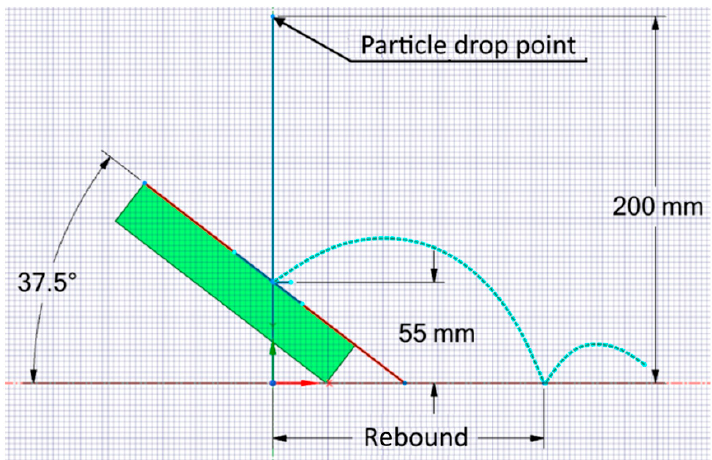
Figure 4. Restitution coefficient "ore-ore" experiment conditions.